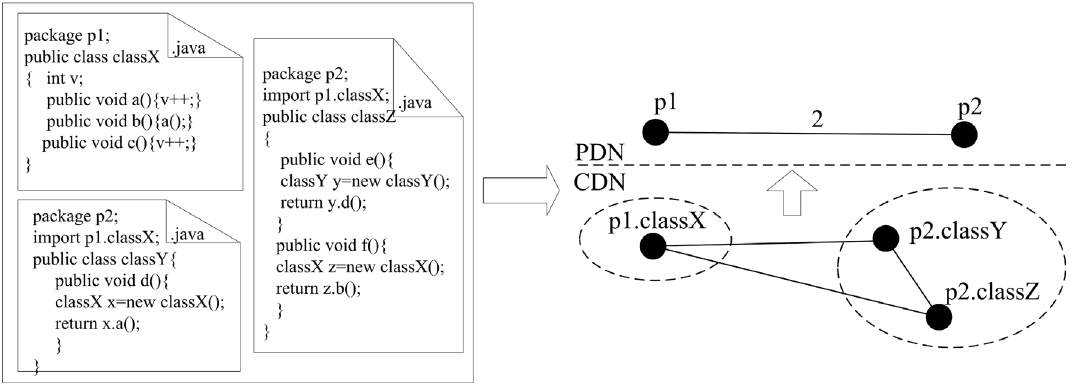
Figure 2. A Simple Code Segment and Its Corresponding CDN and